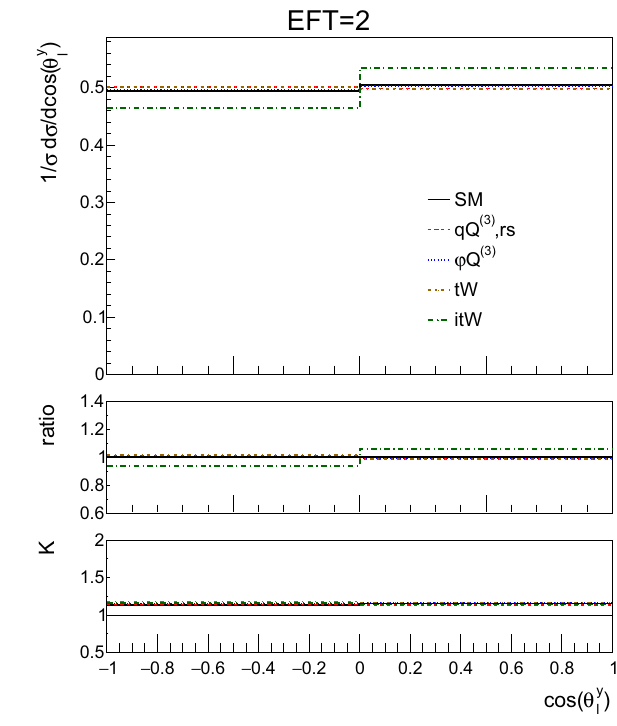
Fig. 16 The NLOdistributions ofthetoppolarisationanglefor theSM and the three effective operators of interest, together with the imaginary part of O tW for the couplings values of Table 2. On the left the shape of the distribution can be seen, on the right the same distribution is shown in two bins where the asymmetry is clearly observed. The ratio shown